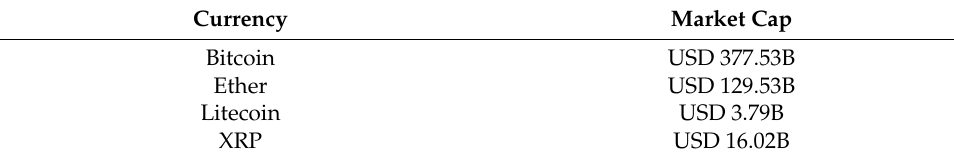
Table 1. Market capitalization as on 30 June